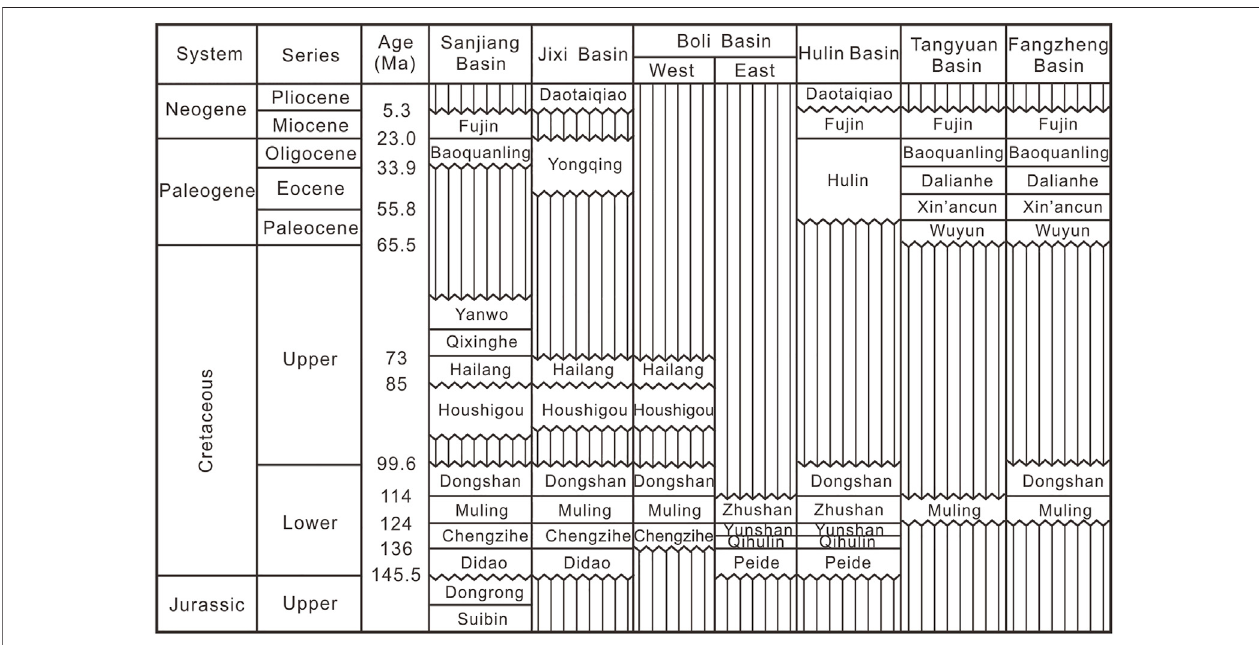
FIGURE 2 | Stratigraphic sedimentary sequences of major basins in Dasanjiang area, NE China (modi fi ed after Meng, 2007; Zhang and Ma, 2010; Zhang F. Q. et al., 2012; Zhang et al., 2016; Zhou et al., 2020). Zig-zag line: erosional unconformity.